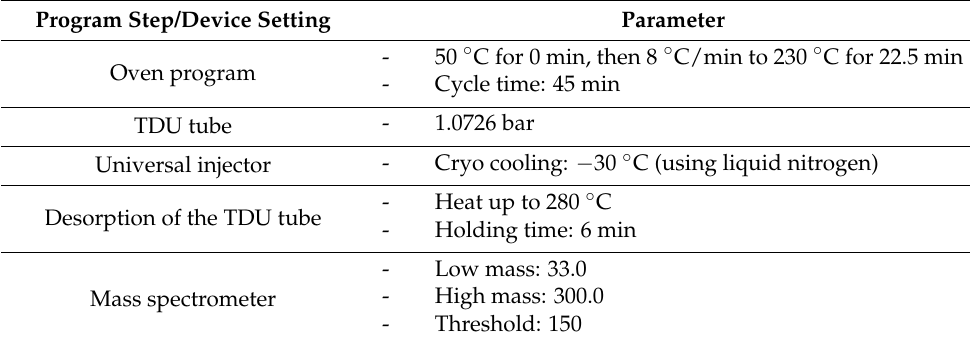
Table 2. Important gas chromatographic parameters.